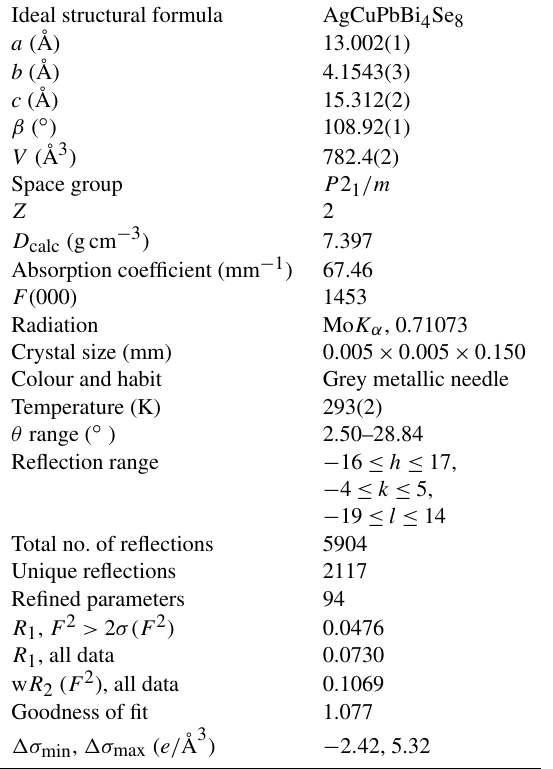
Table 3. Experimental details for the single-crystal X-ray diffrac- tion study of luxembourgite from Bivels, Luxembourg.